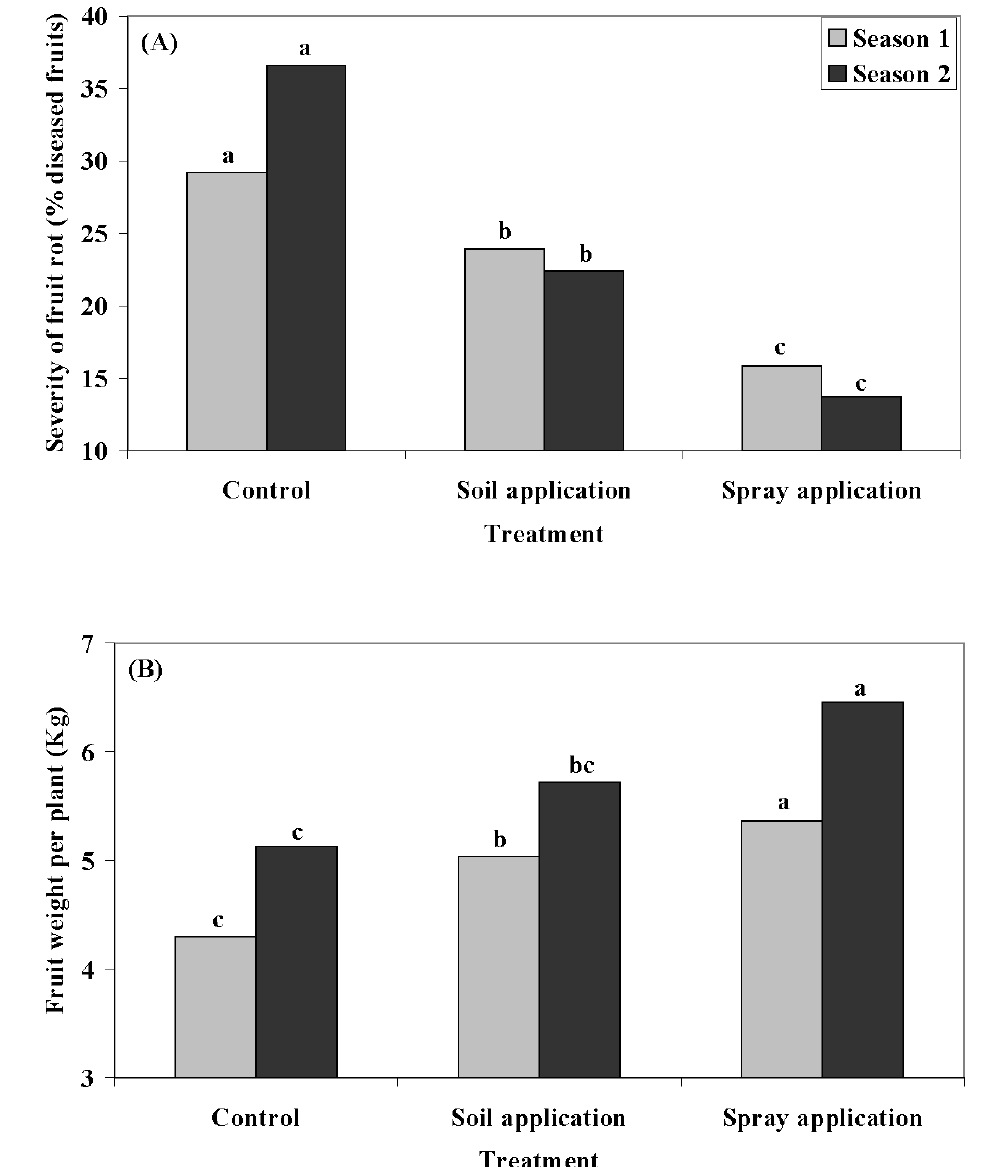
Figure 2 Mean percent diseased fruit (A) and mean fruit yields (B) of winter-season greenhouse cucumber crops that were either untreated or treated with foliar or soil applications of carbendazim. Means within the same category (i.e. season 1 or 2), and which have the same letter are not significantly different P